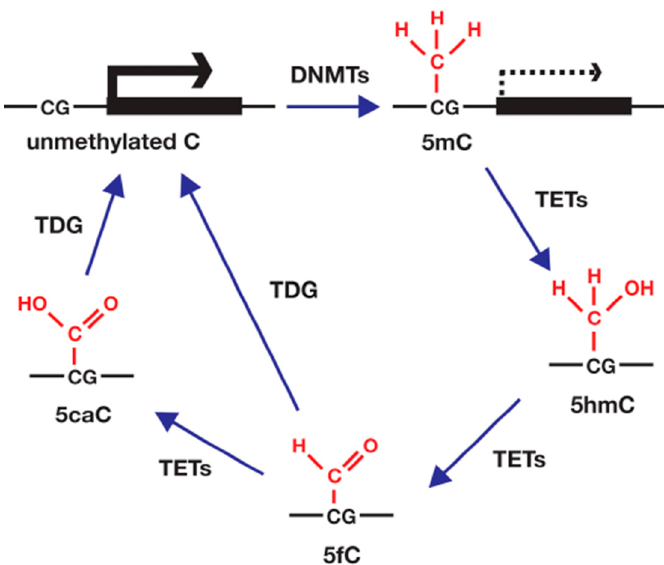
Figure 3. DNA methylation and demethylation are catalyzed by DNA methyltransferases (DNMTs) and ten-eleven translocation (TET) enzymes, respectively. Cytosine at CpG sites is methylated by DNMTs to yield 5-methylcytosine (5mC). The 5mC is hydroxylated by TET enzymes to yield 5-hydroxymethylcytosine (5hmC), which in turn is oxidized to 5-formylcytosine (5fC) and 5-carboxylcytosine (5caC). The 5fC and 5caC are converted to unmethylated C by thymine DNA glycosylate (TDG)-mediated base excision repair.